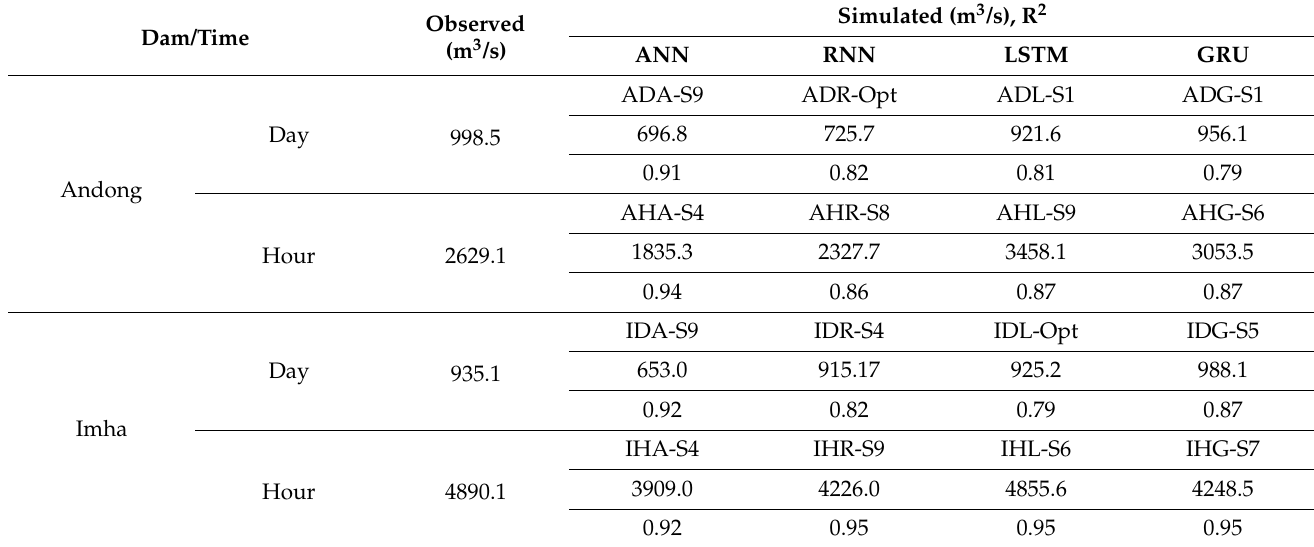
Table 4. Optimal scenario selection.